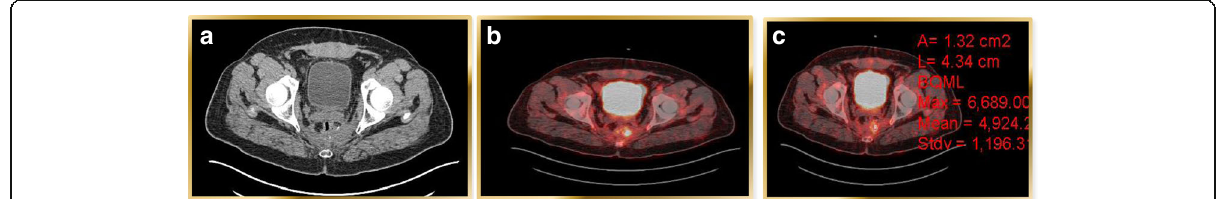
Fig. 1 a Post-operative CT study showing pre-sacral soft tissue density tumefaction. b PET/CT fused image with focal FDG uptake within the left para median aspect of the post-operative fibrosis using the visual assessment method. c PET/CT fused image with SUV max of the lesion 6.6 reflecting local recurrence confirmed by histopathological assessment